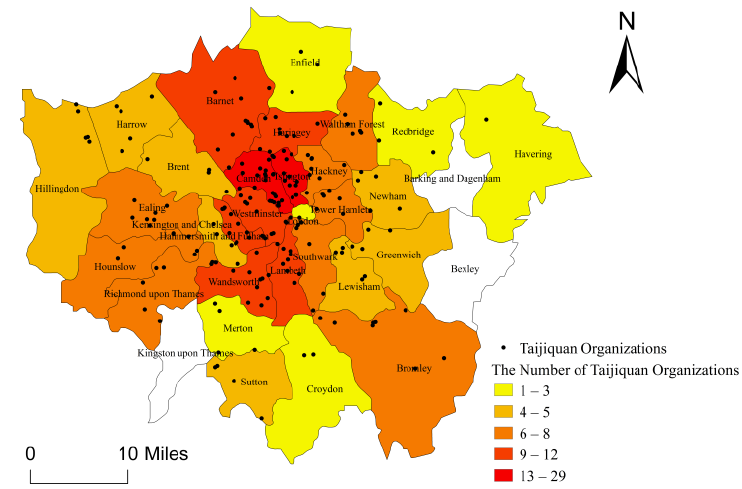
Figure 4. Distribution Density Map of Taijiquan Organizations in Boroughs of London.